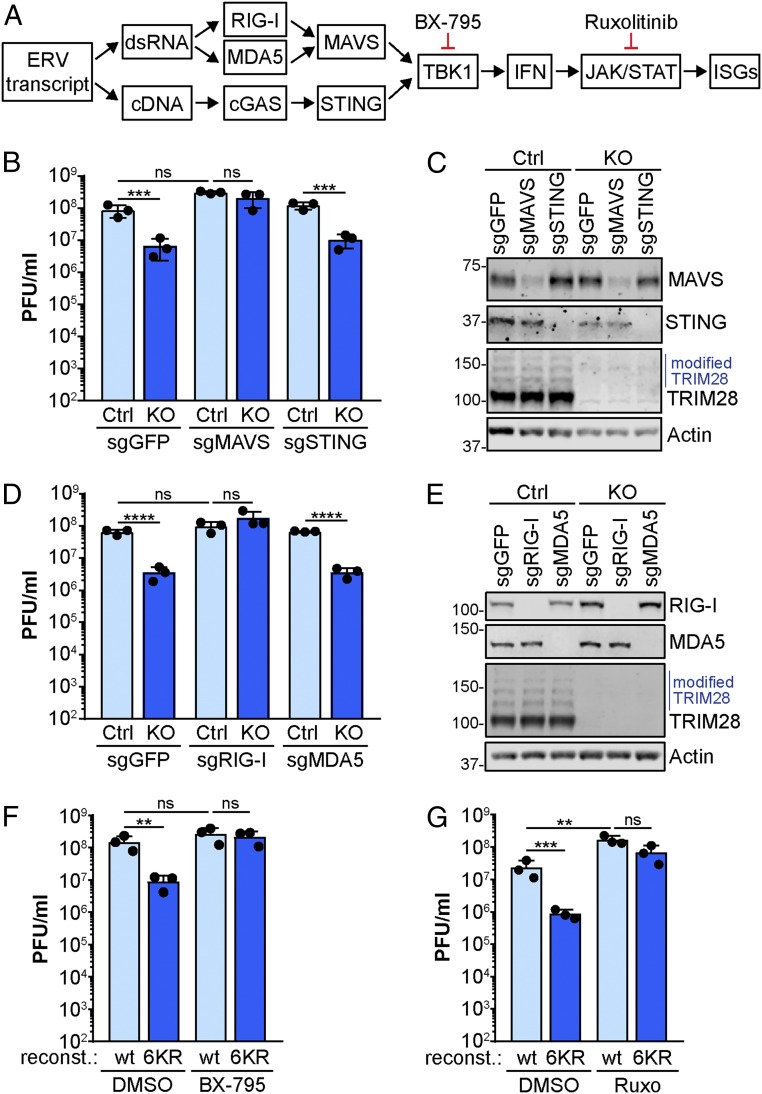
Antiviral activity of SUMOylation-deficient TRIM28 relies on dsRNA-mediated IFN induction and signaling pathways. (A) Schematic showing the canonical IFN signaling cascade triggered by ERV transcripts and leading to ISG expression. Stages of action of specific small-molecule inhibitors are shown. (B) TRIM28-KO (and Ctrl) A549 cells were transduced with lentiviruses expressing Cas9 and 3 different sgRNAs targeting MAVS, STING, or GFP (negative control). Selected cell pools were subsequently infected with IAV (MOI = 0.001 PFU per cell) and supernatants were collected at 72 hpi prior to titration. (C) Cells generated for B were processed for western blot to assess knockout efficiency. Data are representative of at least 2 independent experiments. (D) TRIM28-KO (and Ctrl) A549 cells were transduced with lentiviruses expressing Cas9 and 3 different sgRNAs targeting RIG-I, MDA5, or GFP (negative control). Selected cell pools were subsequently infected with IAV (MOI = 0.001 PFU per cell) and supernatants were collected at 72 hpi prior to titration. (E) Cells generated for D were treated with IFNα2 (1,000 U/mL, 16 h) and processed for western blot to assess knockout efficiency. Data are representative of at least 2 independent experiments. (F and G) TRIM28-KO A549 cells reconstituted with wt TRIM28 or TRIM28-6KR were infected with IAV (MOI = 0.001 PFU per cell) in the presence or absence of the TBK1 inhibitor BX-795 (0.5 µM; F) or the JAK1 inhibitor ruxolitinib (4 µM; G) for 72 h, prior to titration of supernatants. For B, D, F, and G, mean values from 3 independent experiments are plotted, error bars represent SDs, and individual data points are shown. Significance was determined by 1-way ANOVA (**P < 0.01, ***P < 0.001, ****P < 0.0001; ns, nonsignificant).